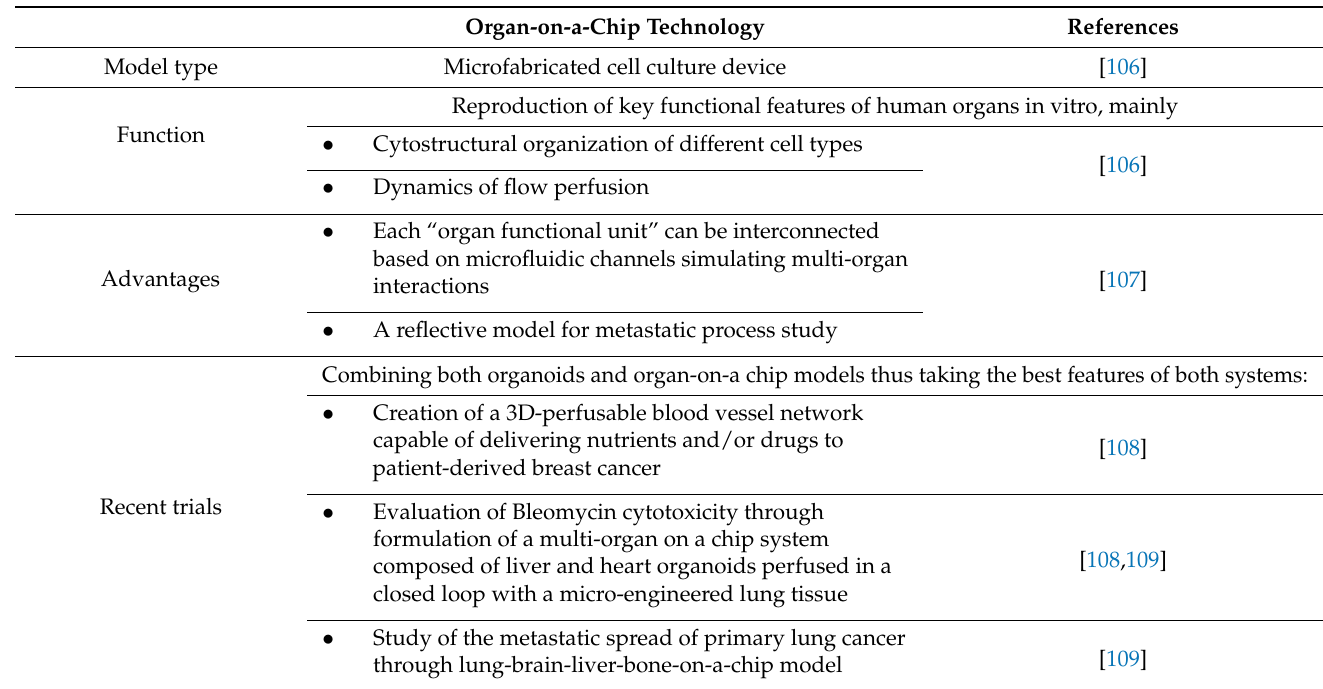
Table 3. New approach derived from